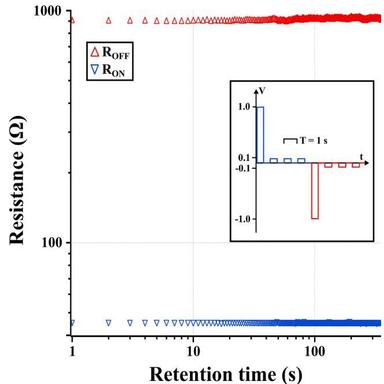
Measured retention of a Cu/HfO2/Pt memristor. The inset shows the programmed voltage pulses train. After a writing pulse of + 1 V which switches the device to the ON state, a train of 350 reading pulses of + 0.1 V is applied, then an erasing pulse of − 1 V switches the device to the OFF state and a train of 350 reading pulses of − 0.1 V is applied. Each pulse lasts 0.5 s.